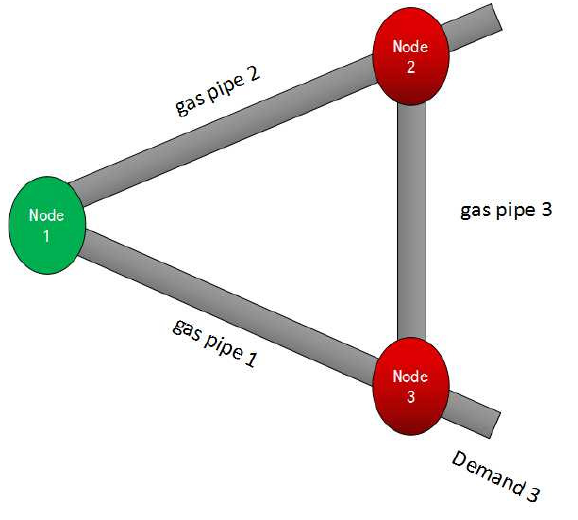
Figure 7. Topology of the typical